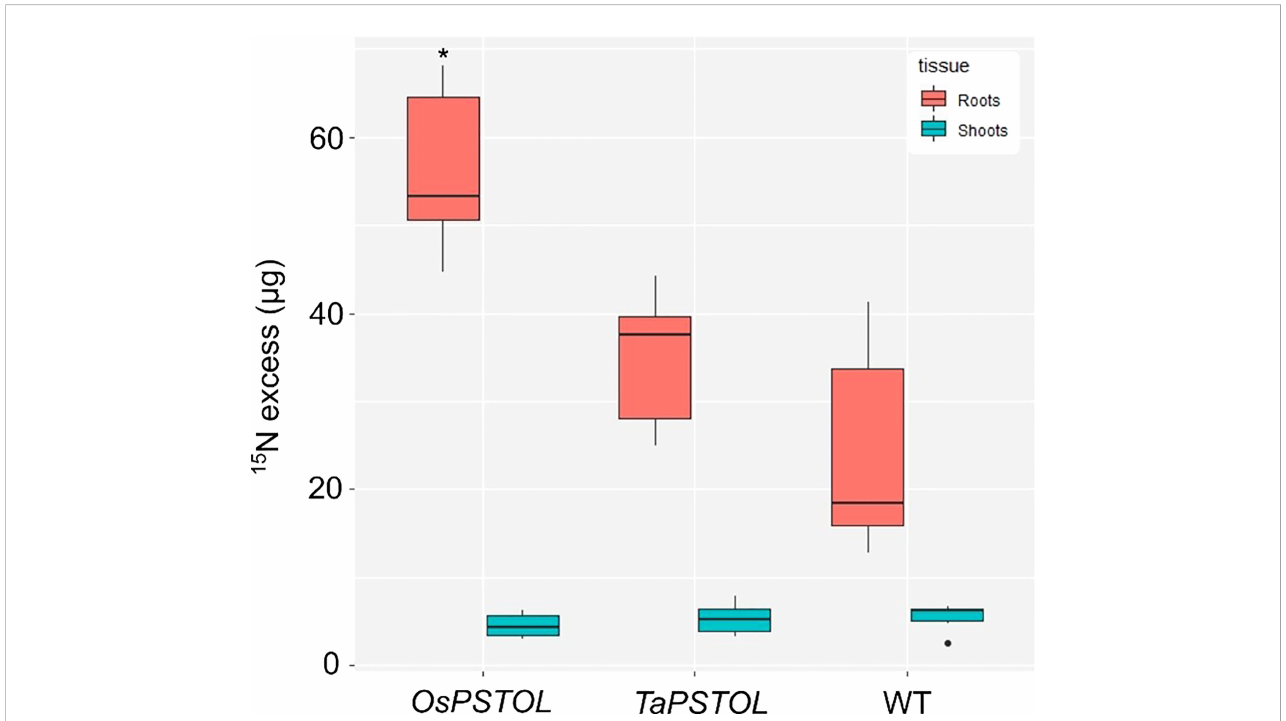
FIGURE 6 Uptake of 15 N in the roots and shoots of overexpression lines expressing either OsPSTOL (OsOE-3) or TaPSTOL (TaOE-1) relative to WT. Data are shown as mean values (central line), lower and upper quartiles (box), minimum and maximum values (whiskers), and outliers as individual points. The statistical analysis was performed with ANOVA and post hoc Tukey test. Asterisks indicate a signi fi cant difference ( p <0.05) between WT and an OE line in the same